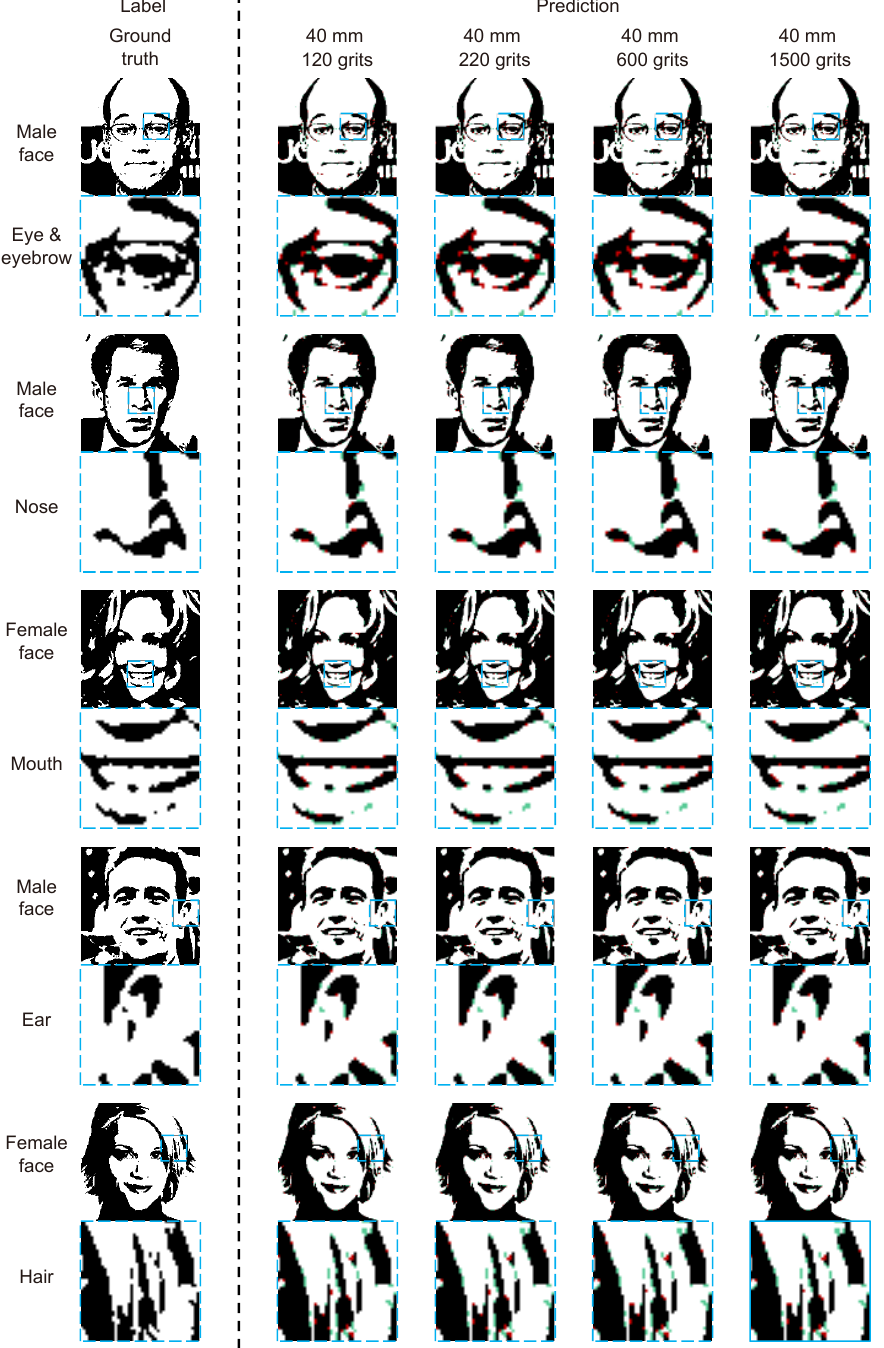
Fig. 6 | The ground truth (left column) and prediction (right column) of the trained SpT UNet with the camera placed at 40 mm away from the focal plane. The prediction results are overlaid with the true positive (white), false positive (green), and false negative